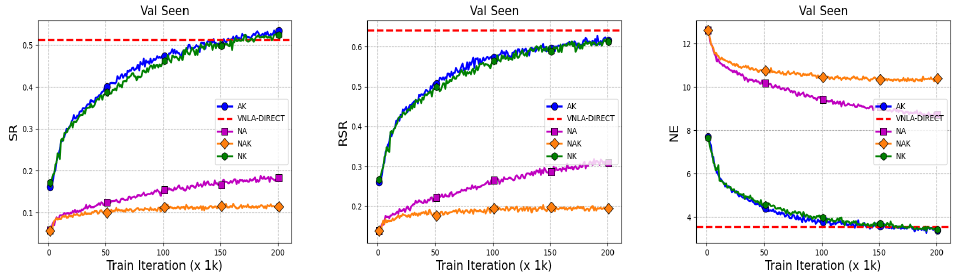
Figure 4. Comparison of the learning curves during training. AK represents our AKCR-AH model.